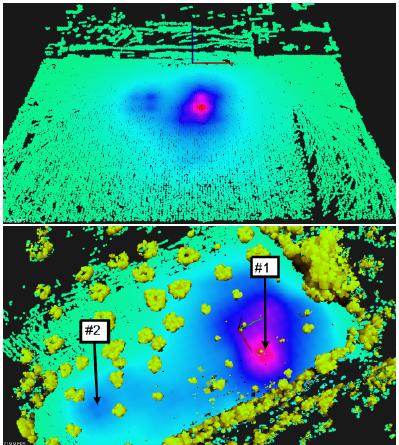
Figure 25. Heatmap: CPM estimation at h = 1 from the ground, at each one of the scenarios. Top- left : Scenario A (max 109 CPM). Top-right : Scenario B (max 272 CPM). Bottom : Scenario C (max 347 CPM).